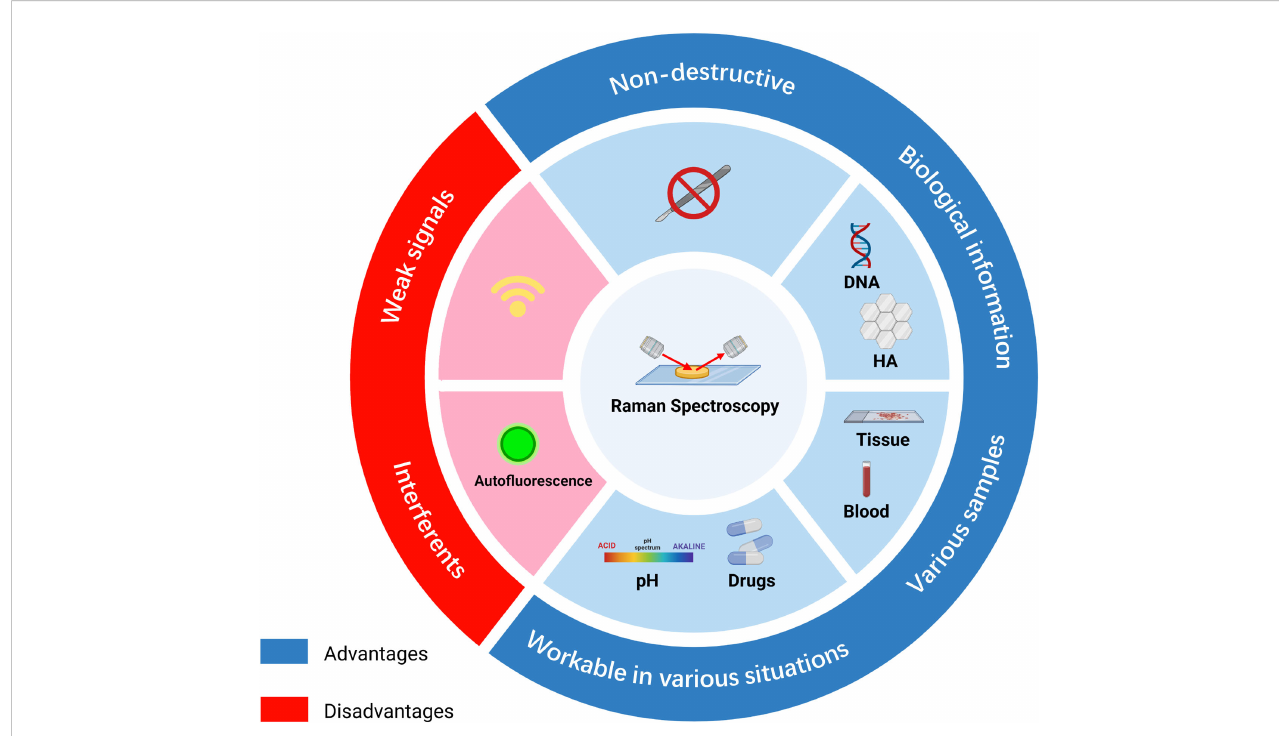
FIGURE 2 Summary of the advantages and disadvantages of Raman spectroscopy in diagnosis. RS possesses non-destructive properties and is workable under various environments, such as different pH or drug conditions. RS can be used to analyze tissue, blood, or supernatant samples and provides biomolecular information on DNA or biomarkers. However, signals of RS are weak and can be affected by other interferents, such as fl uorescence. HA,